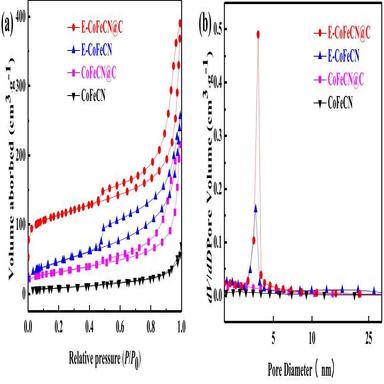
(a) N2 adsorption-desorption isotherms and (b) the pore-size distribution plots of different samples.